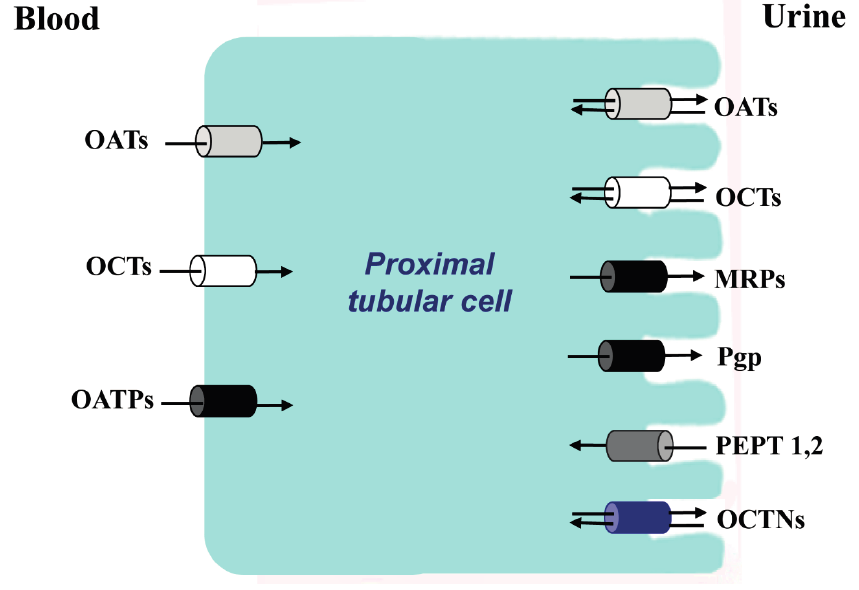
Figure 1. The principal families of membrane transporters in proximal tubular cells. In white color, organic cations transporters; in gray color, organic anionic transporters; in black color, anions transporters that also transport cations, zwitterions and neutral substances; in dark gray color, oligopeptides transporters; in blue zwitterion